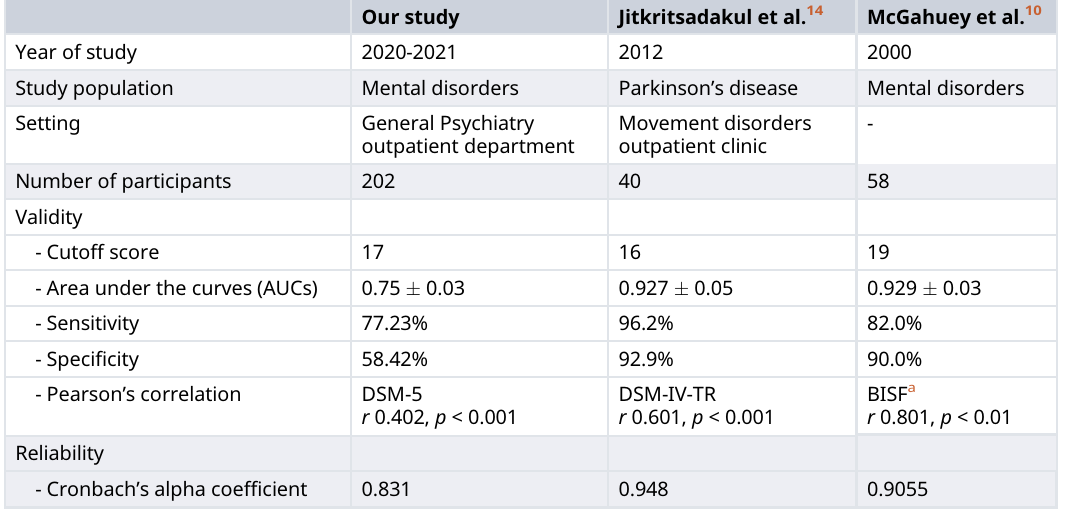
Table 2. The comparison between two ASEX-Thai studies and the original ASEX.